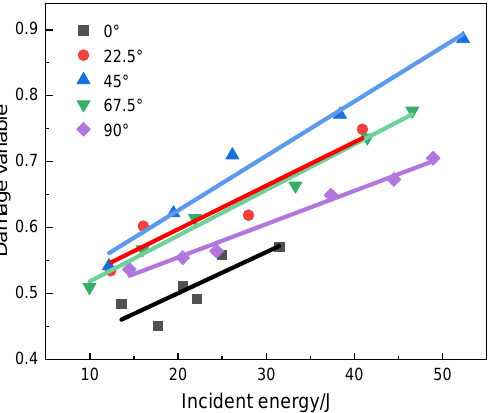
Figure 9. The relationship curve between the damage variable and incident energy.